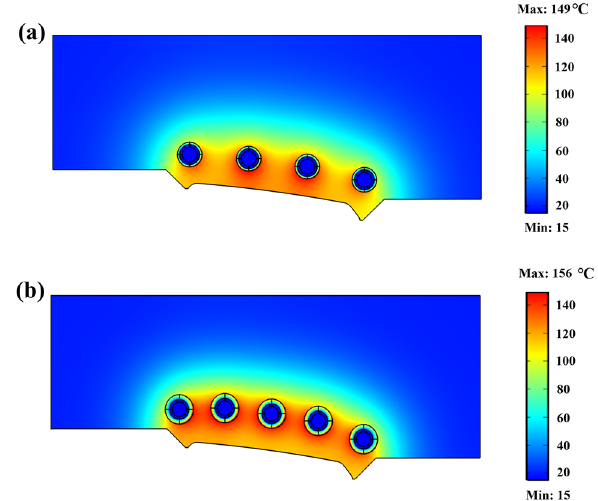
Fig. 9 a Design flow for layout arrangement of induction coils in RTCM mold; b mesh model and boundary conditions for mold heat